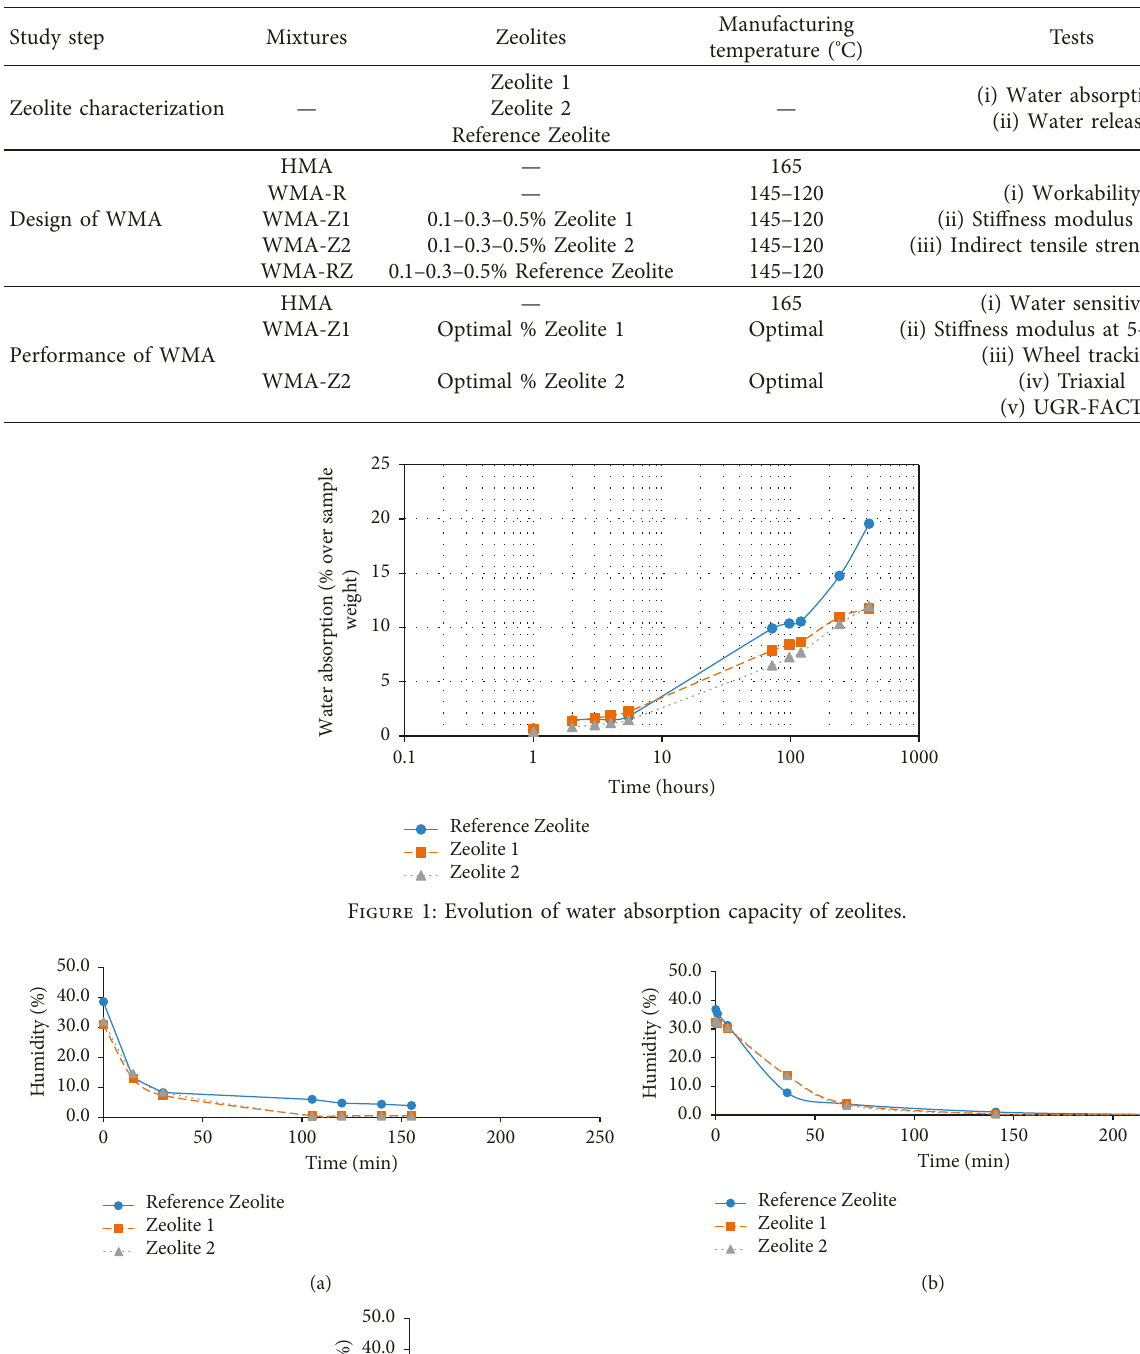
Table 4: Testing plan.